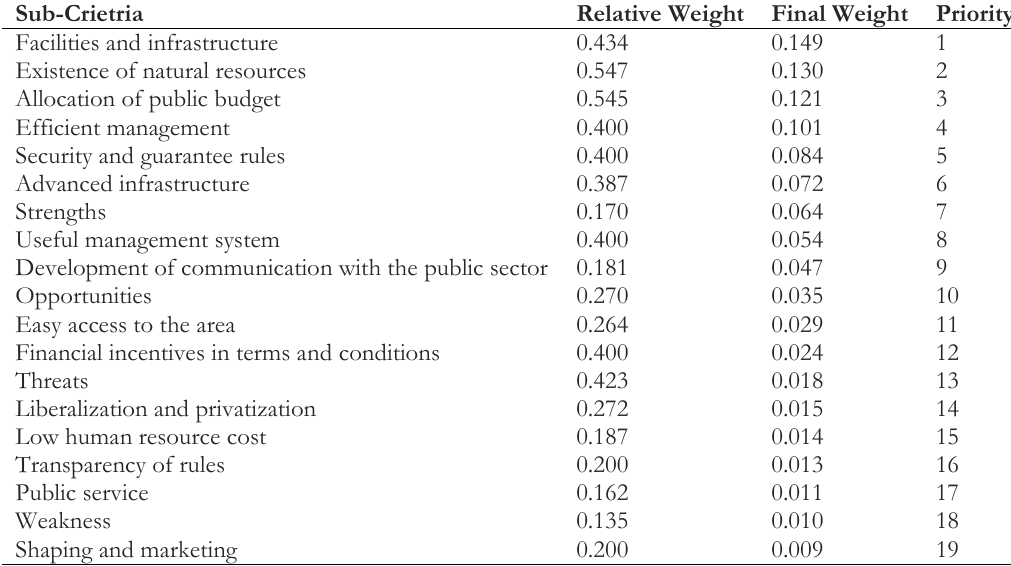
Table 5. Interpretation of third-level